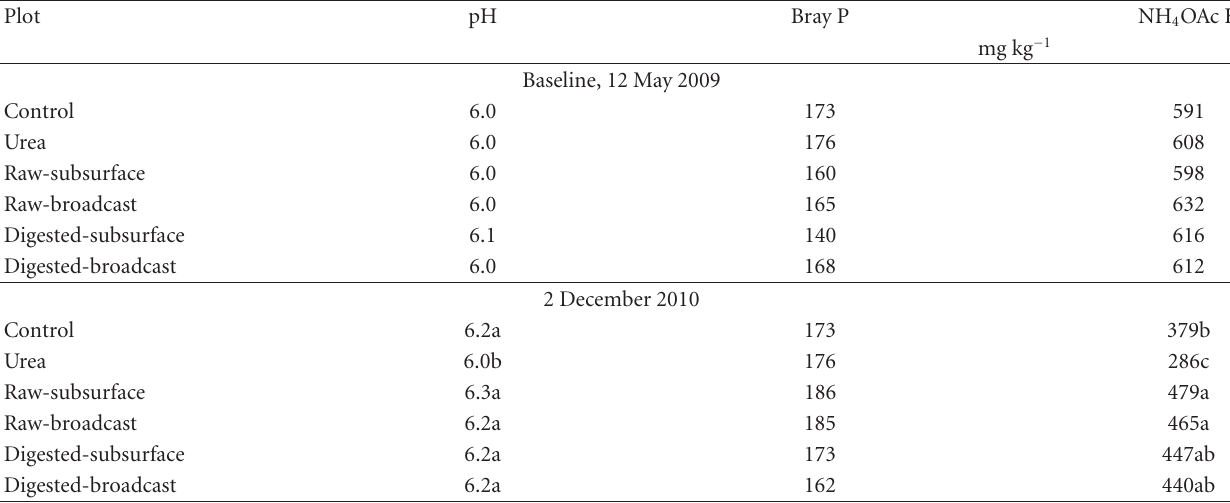
Table 5: Soil pH, Bray-P, and exchangeable K at start of experiment and after two years of slurry applications.